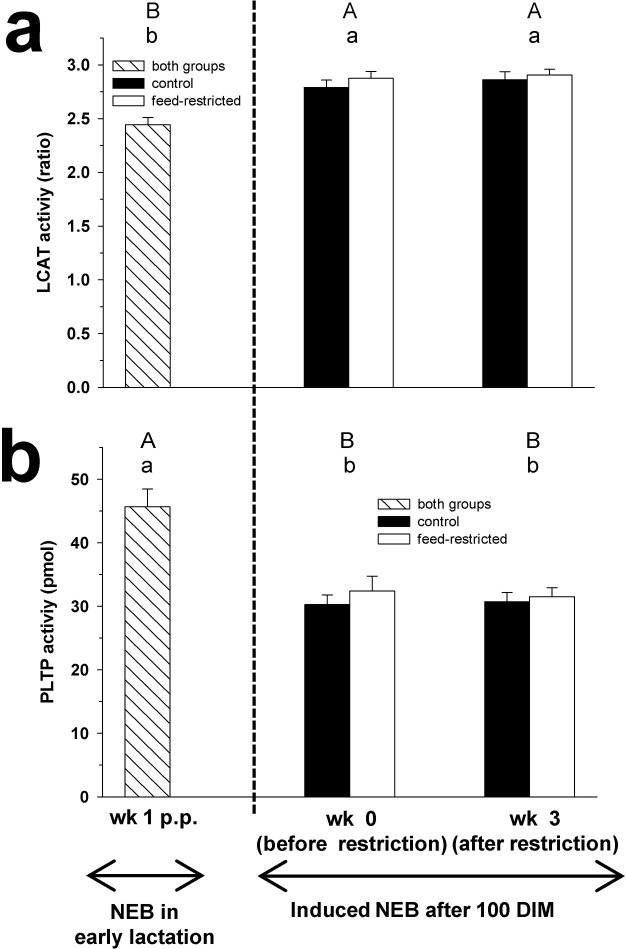
LCAT and PLTP activities.Plasma activity of lecithin:cholesterol acyltranserase (LCAT; Fig 4a) and phospholipid transfer protein (PLPT; Fig 4b) in week 1 p.p., and before (week 0) and after (week 3) feed restriction in mid-lactation. Changes over time within the groups are marked with superscripts (A and B for the control group (CON); a and b for the feed-restricted group (RES); P < 0.05). Data are presented as means ± standard error of the mean.